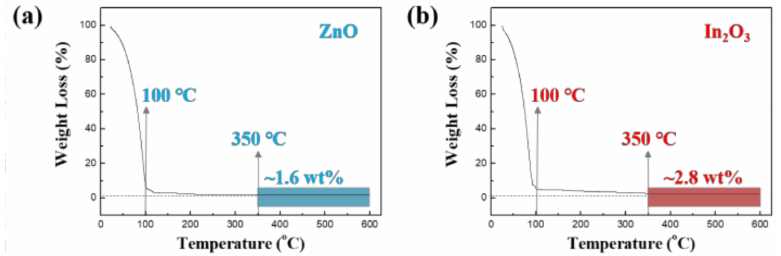
Figure 1. Thermogravimetric analysis (TGA) curves of ( a ) ZnO and ( b ) In 2 O 3 precursor